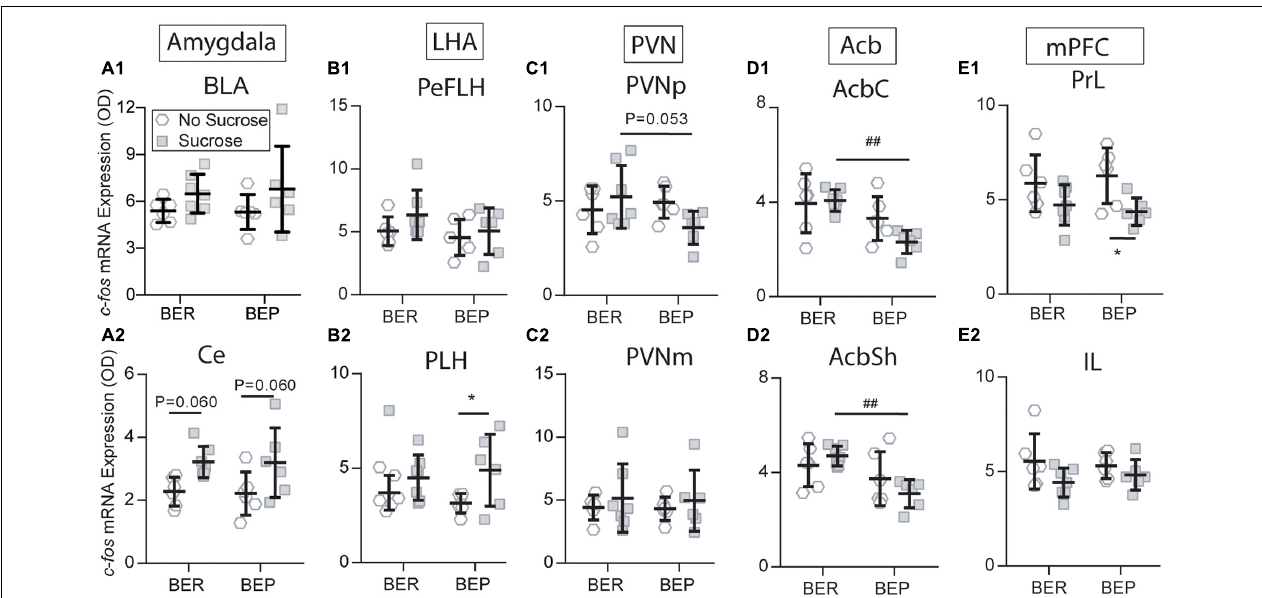
FIGURE 7 | Sucrose changed the c-fos expression in response to the fear conditioning in the amygdala (A1,A2) , LHA (B1,B2) , PVN (C1,C2) , Acb (D1,D2) , and mPFC (E1,E2) . Acb, nucleus accumbens; AcbC, nucleus accumbens core; AcbSh, nucleus accumbens shell; BLA, basolateral amygdala; Ce, central amygdala; IL, infralimbic mPFC; LHA, lateral hypothalamus; mPFC, medial prefrontal cortex; PeFLH, perifornical part of the lateral hypothalamus; PLH, peduncular part of the lateral hypothalamus; PrL, prelimbic mPFC; *significantly different ( p < 0.05) from the BEP-No Sucrose group. ## Significantly different ( p < 0.01) from the BER-Sucrose